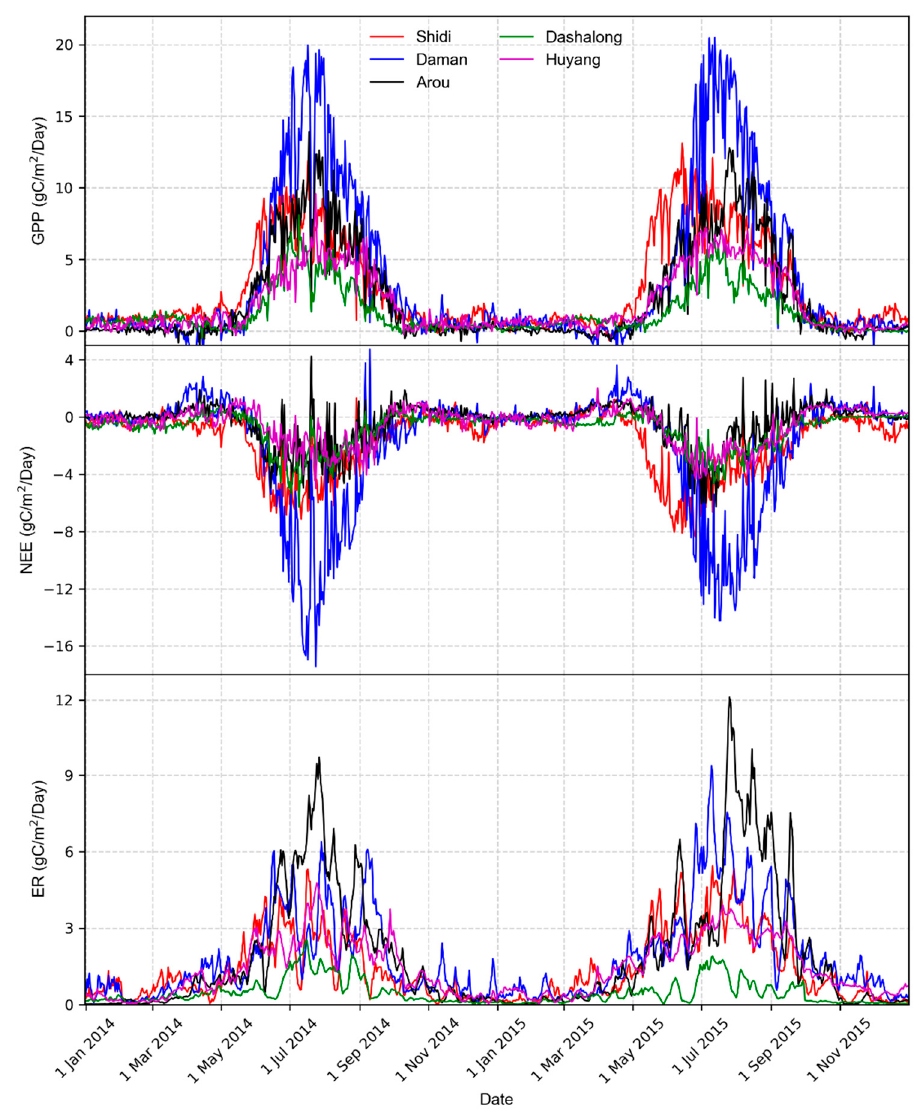
Figure 2. Seasonal carbon flux dynamics at the five study sites. Table 3. Annual carbon flux at the five study sites in the Heihe River Basin.